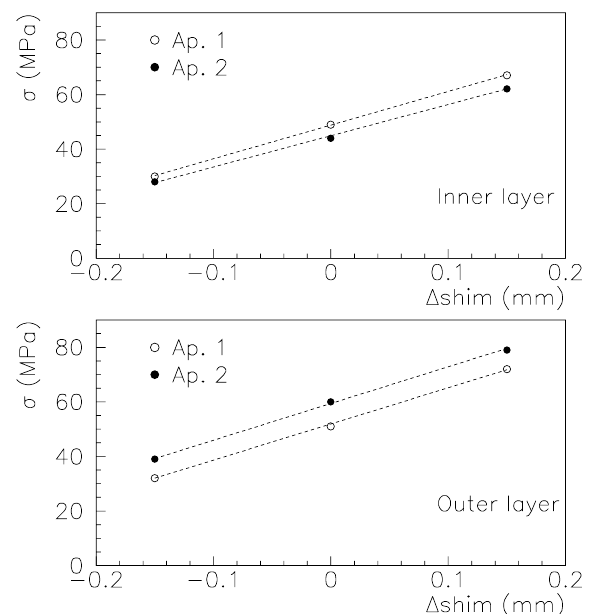
FIG. 4. Prestress s (MPa) versus shim thickness variation (mm) for the inner and outer layers and for the two apertures (Ap. 1 and Ap. 2), experimental data, and linear fit.